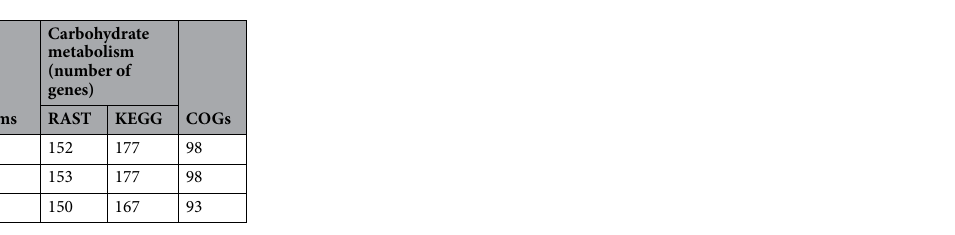
Figure 6. The number of genes assigned in KEGG ( A ) and COGs ( B ) categories. KEGG Kyoto Encyclopedia of Genes and Genome, COGs Clusters of Orthologous Groups.